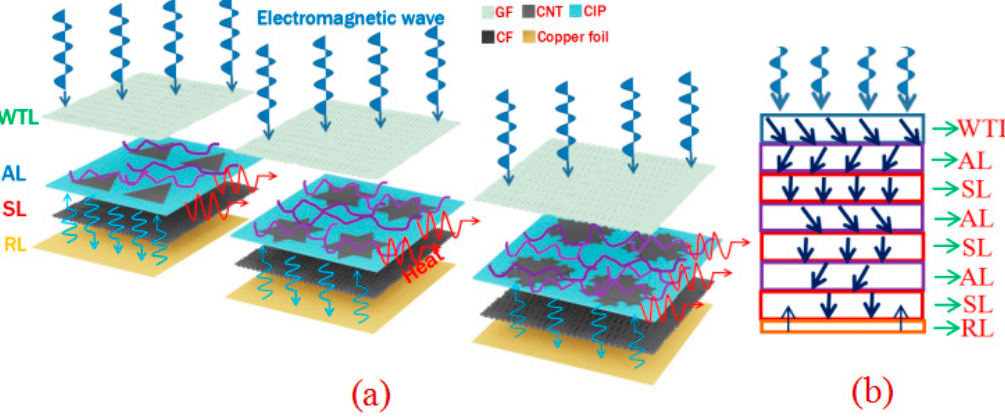
Figure 6. Schematic diagram of shielding mechanism ( a ) main perspective ( b ), sectional view.